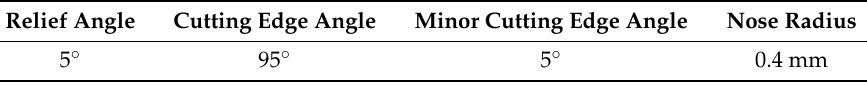
Table 3. Geometrical parameters of insert fixed in the tool holder.